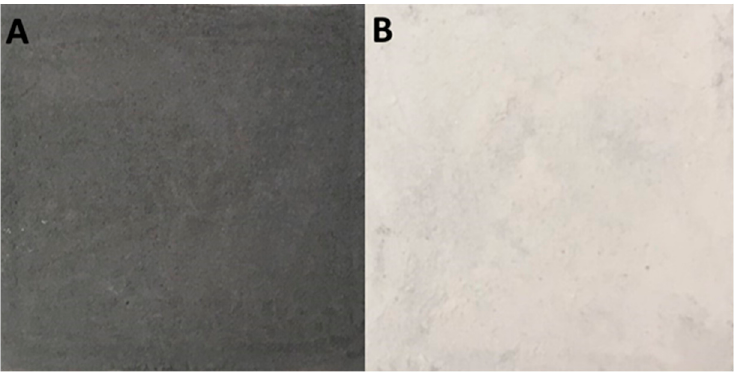
Figure 1. Picture of immobilised ( A ) rGO/TiO 2 nanocomposite and ( B ) pure TiO 2 .